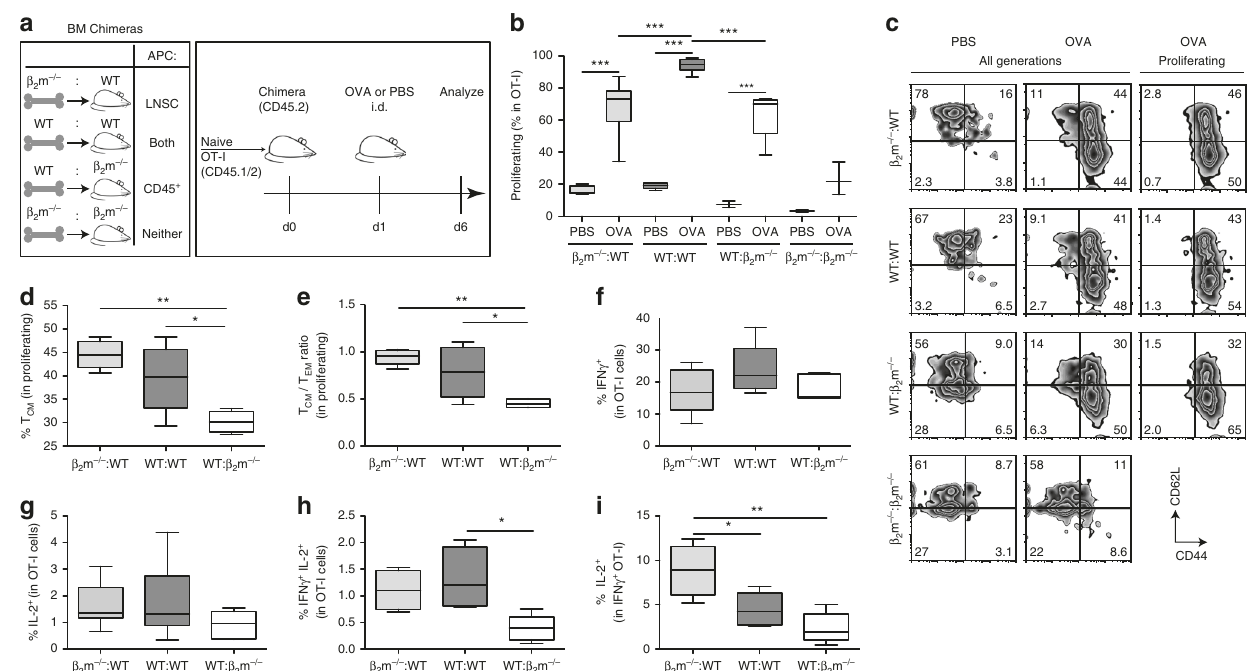
Fig. 1 CD8 + T cells educated by lymph node stromal cells display memory-like characteristics. a Experimental schematic, highlighting nomenclature for BM chimeras according to MHCI-competent cell types (left), and timeline (right) for transfer of CFSE-labeled OT-I cells (i.v.), OVA challenge (50 μ g; i.d.), and sacri fi ce. Skin-draining LNs were analyzed by fl ow cytometry. b Quanti fi cation of cell proliferation via CFSE dilution on transferred OT-I cells. c Representative contour plots of CD44 and CD62L expression gated on all transferred cells (left, center) or on proliferating transferred cells (right). d , e Phenotype of proliferating, transferred cells quanti fi ed according to d frequency of T CM (CD44 + CD62L + ) and e the ratio of T CM (CD44 + CD62L + ) to T eff/EM (CD44 + CD62L − ). f Frequency of intracellular IFN γ + , g IL-2 + , and h bifunctional IFN γ + IL-2 + cells among all transferred cells after 5 h ex vivo re-stimulation with SIINFEKL followed by intracellular staining. i Frequency of IL-2 + cells within IFN γ + OT-I cells. Representative data pooled from two independent experiments ( n = 3 – 5 each). Whiskers: Min to Max, median c , e , f ; * p ≤ 0.05, ** p ≤ 0.01, *** p ≤ 0.001 by one-way ANOVA followed by Bonferroni